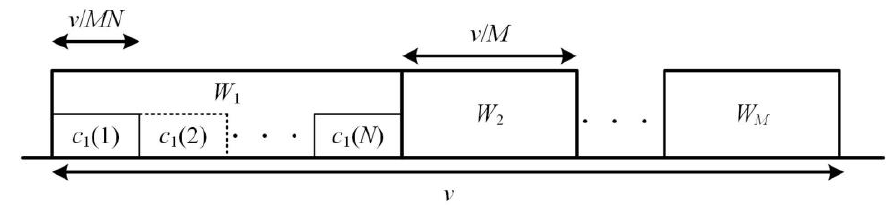
Figure 5. PSD of a single spectral amplitude coding (SAC) label ( W 1 , C 1 ).